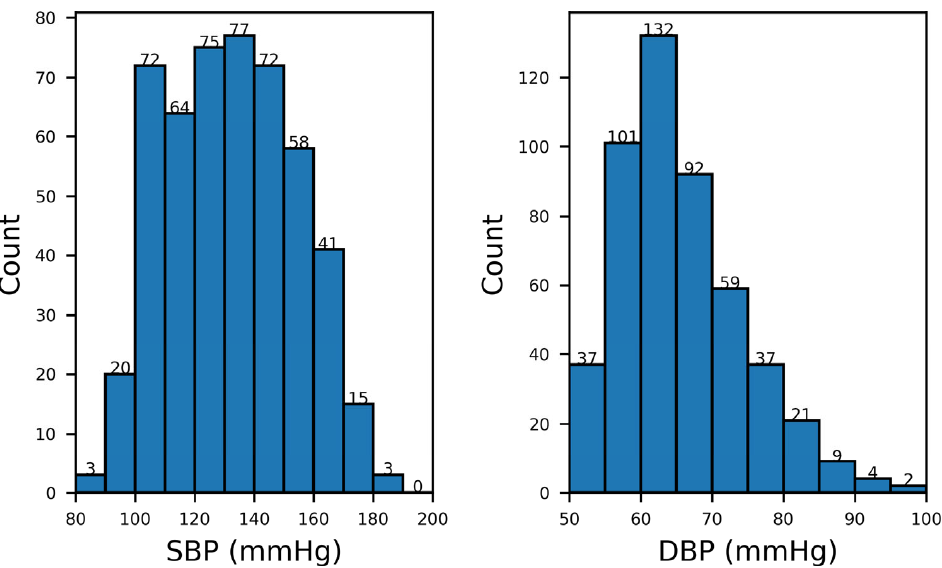
Figure 3. Histogram distributions of SBP and DBP of the data set. This figure shows that the dataset has a population with a large spectrum of blood pressure values. The used dataset can test the model’s performance under different blood pressures. Note that SBP = Systolic blood pressure and DBP = Diastolic blood